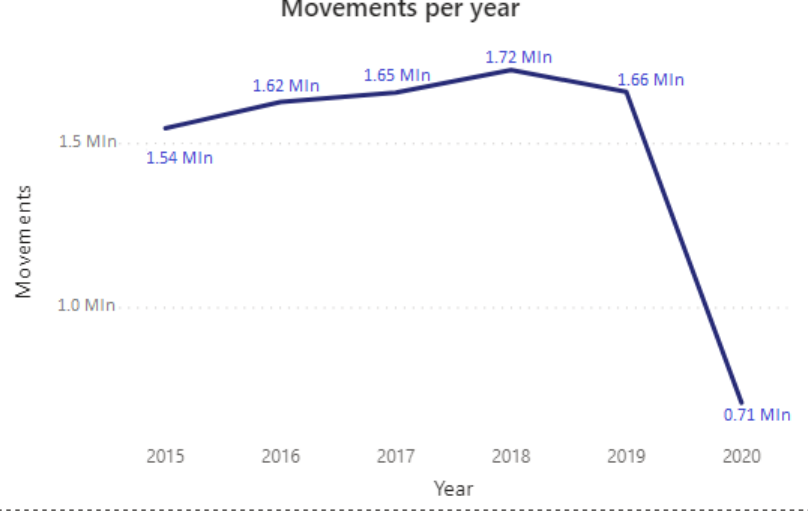
Figure 7. Yearly number of airport movements in Italy (2015–2020).